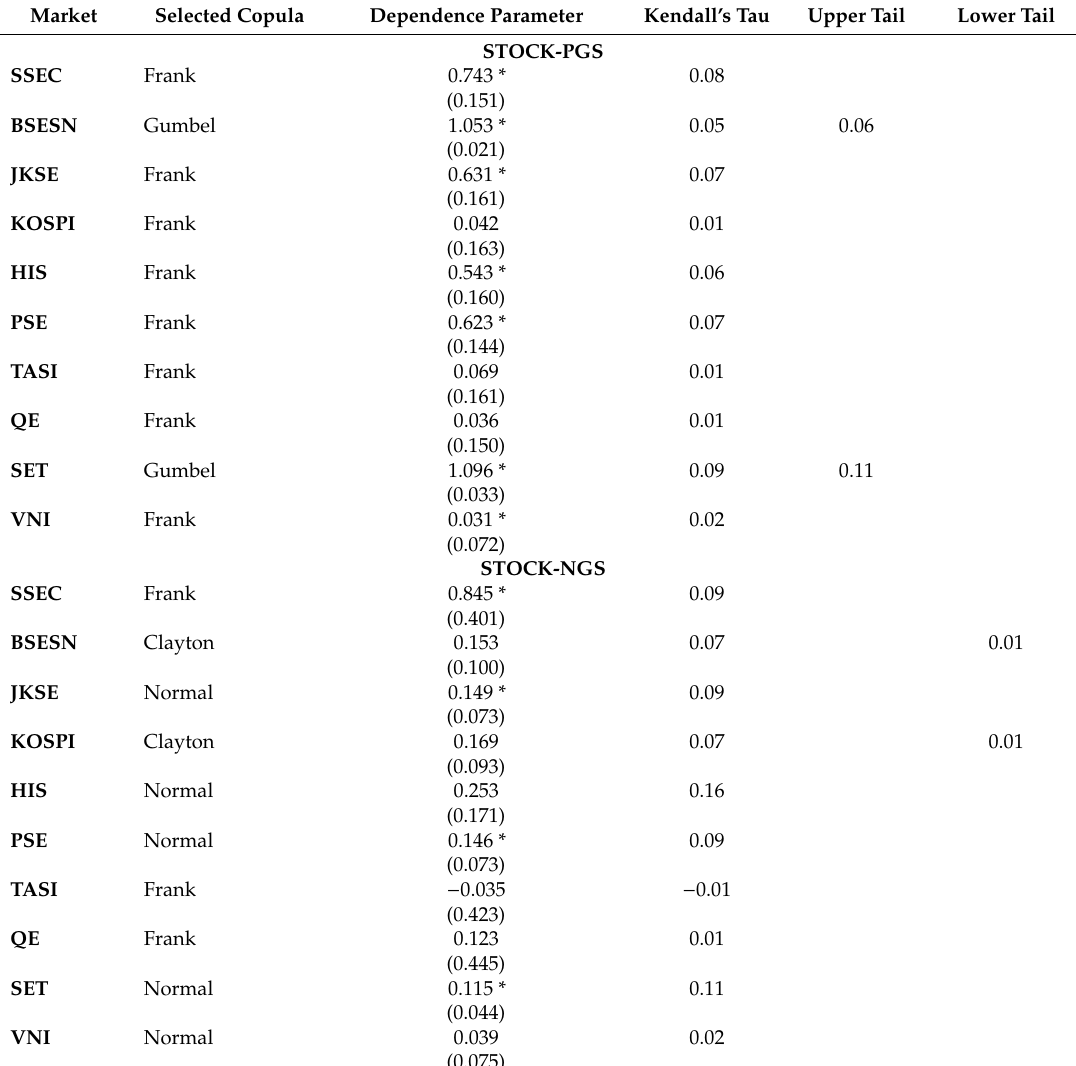
Table 8. Dependence measures of the selected